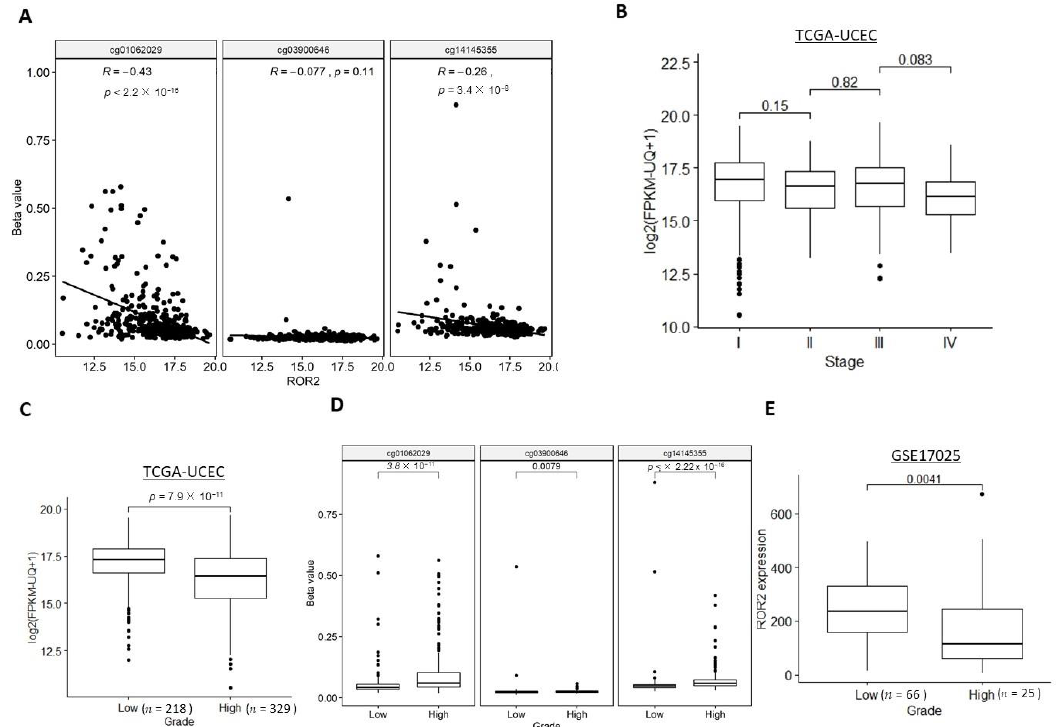
Figure 2. ROR2 mRNA expression level was downregulated in high grade EC due to hypermethylation of ROR2 promoter region in the TCGA-UCEC and GSE17025 datasets. ( A ). ROR2 expression was negatively correlated with methylation level at cg01062029 and cg14145335 sites in TCGA-UCEC ( p < 0.001). No significant correlation was observed for the cg03900646 site. ( B ). ROR2 expression was not significantly different between adjacent stages in TCGA-UCEC. ( C ). ROR2 expression was significantly lower in high grade compared to low grade EC in TCGA-UCEC ( p < 0.001). ( D ). Methylation level of all the three CpG sites (cg01062029, cg03900646 and cg14145355) located in the ROR2 promoter was significantly different between high and low grade EC ( p < 0.001, p = 0.008, p < 0.001 respectively). ( E ). ROR2 expression was significantly lower in high grade compared to low grade EC in GSE17025 ( p = 0.004).